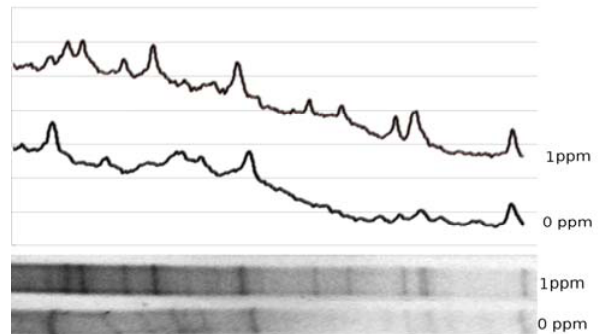
Figure 1: DGGE profile of 16S marker in low-Pb experiment. Bottom part, gel image; top part, digitized density profile of the gel.